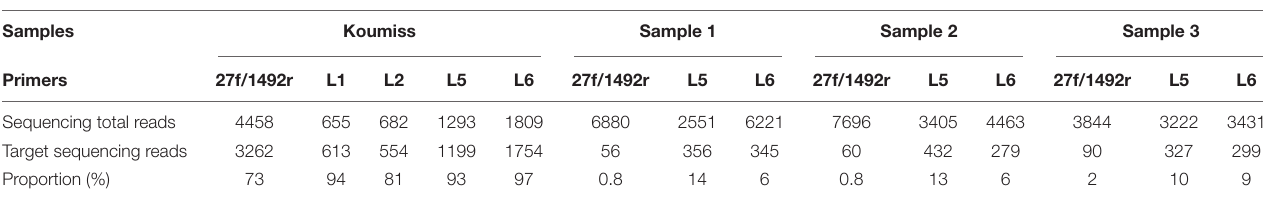
TABLE 3 | Sequencing reads from samples amplified by various